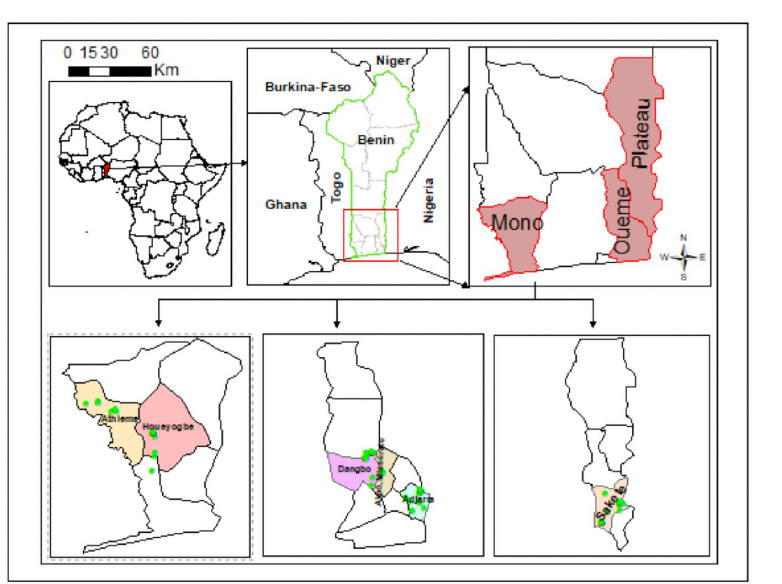
Fig 1. Location of study sites showing banana gardens. (green dots) Banana fields